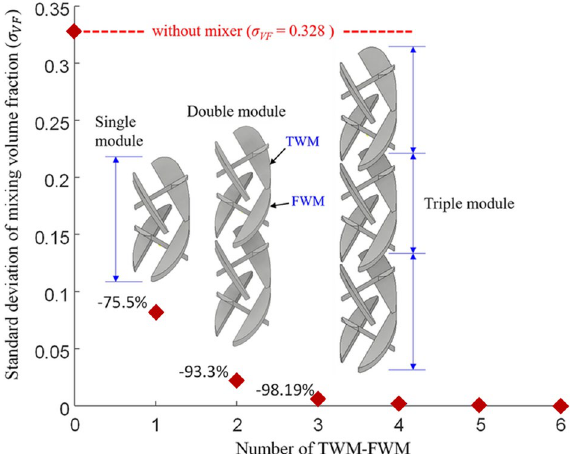
Figure 7. Mixing performance according to the number of optimized TWM-FWM modules; as the number of TWM-FWM modules increases, σ VF decreases exponentially. When the TWM-FWM module number is three, σ VF decreases by 98.19%.